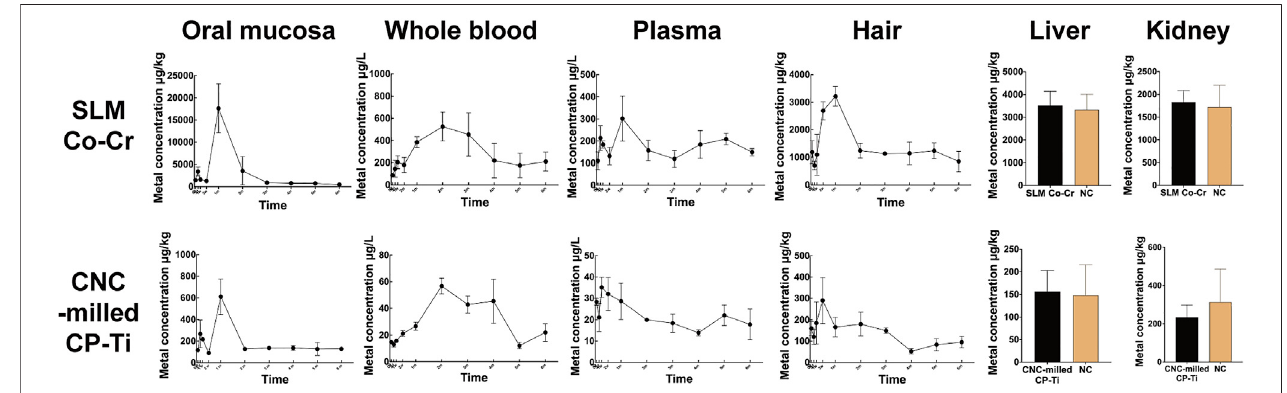
FIGURE 2| Total metal ion concentrations oftrace metals in theoralmucosa, whole blood, plasma, hair, liver, and kidney affected by SLM Co-Cr alloys and CNC- milled CP-Ti. The line graphs and bar charts show that metals released from the SLM Co-Cr alloys and CNC-milled CP-Ti accumulated transiently in the oral mucosa, blood, and hair, but did not signi fi cantly affect the concentrations of trace metals in the liver and kidney.